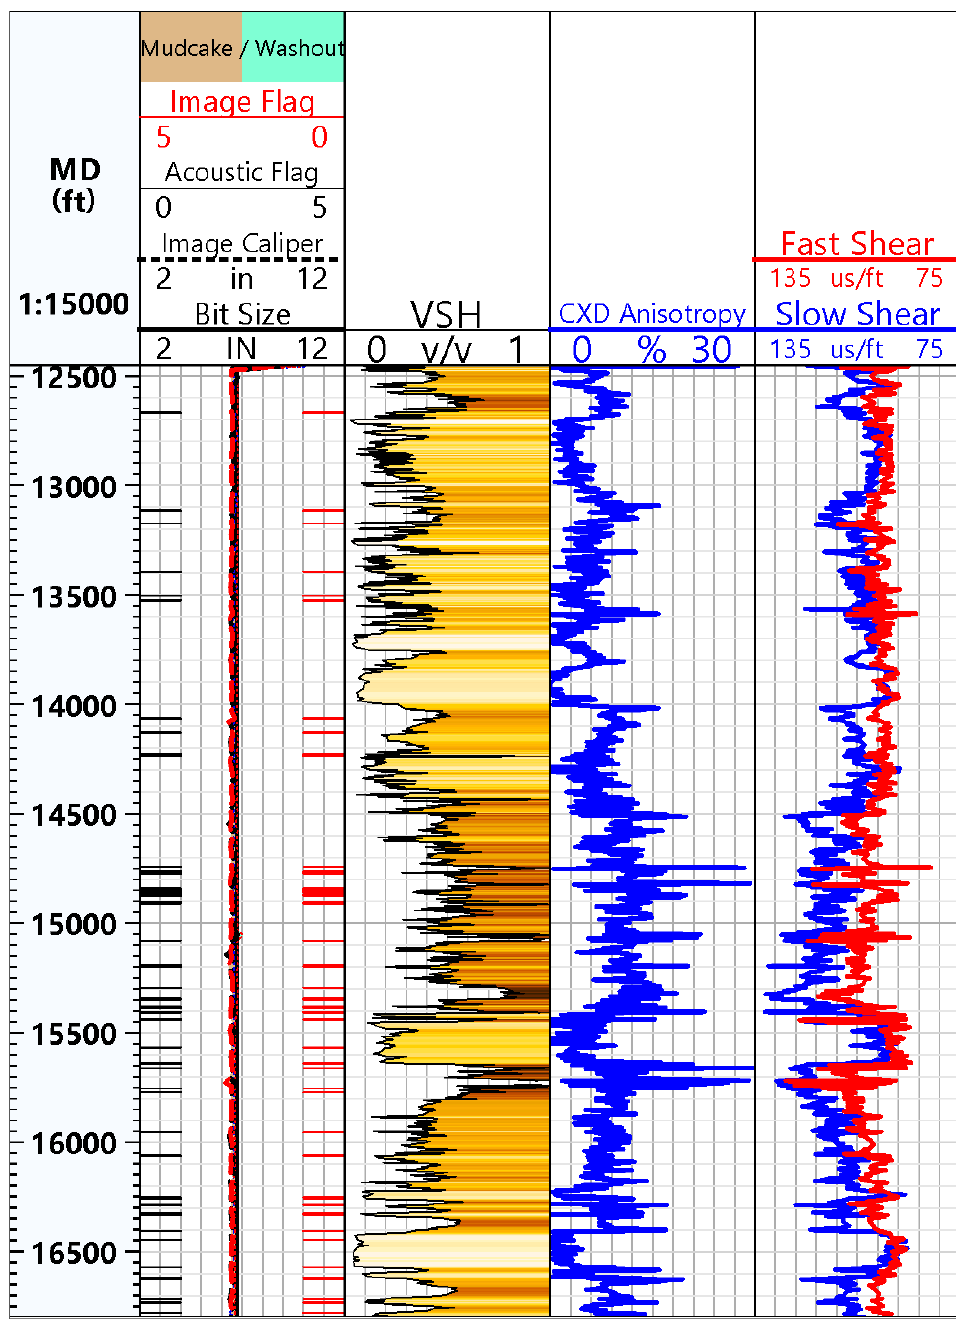
Figure 2. Well logs and observed shear-wave anisotropy. Track 1 shows the image caliper log relative to the bit size and poor acoustic- and image quality flags. VSH in the center track (with units of volume fraction) has color fill of the VSH values with lower VSH in lighter colors (mostly carbonates) and higher VSH values in darker colors (shales). The next track to the right contains the anisotropy curve in blue calculated from measured velocities. The rightmost track contains the processed fast shear (red curve) and slow shear (blue curve) slowness curves used to calculate the anisotropy.